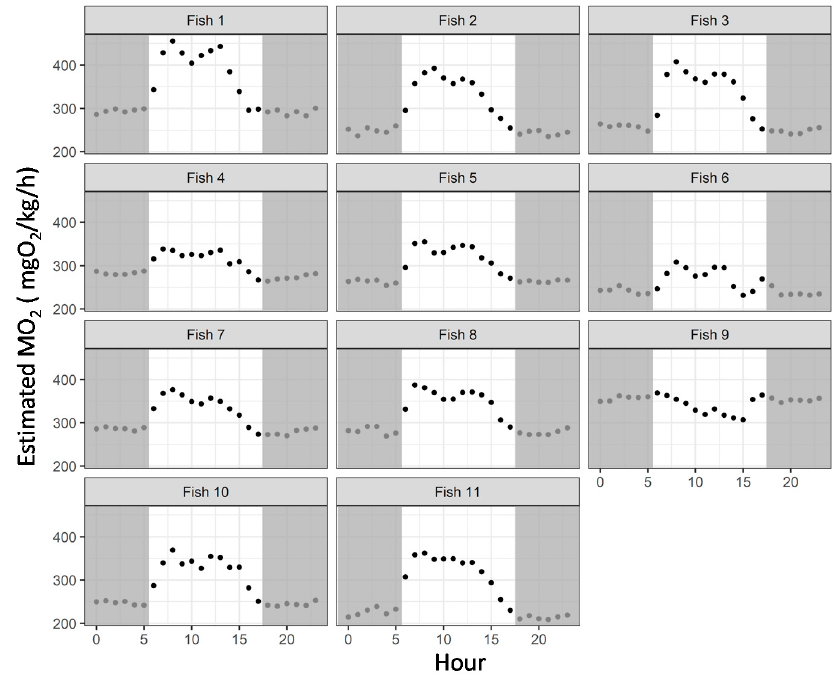
Figure 8. Mean of the hourly estimated oxygen consumption rate (MO 2 , mgO 2 /kg/h) of implanted rainbow trout ( Oncorhynchus mykiss ) over the day and nighttime in the aquaculture facility (n = 11 implanted fish). Dark grey shapes indicate the night period of the photoperiod.